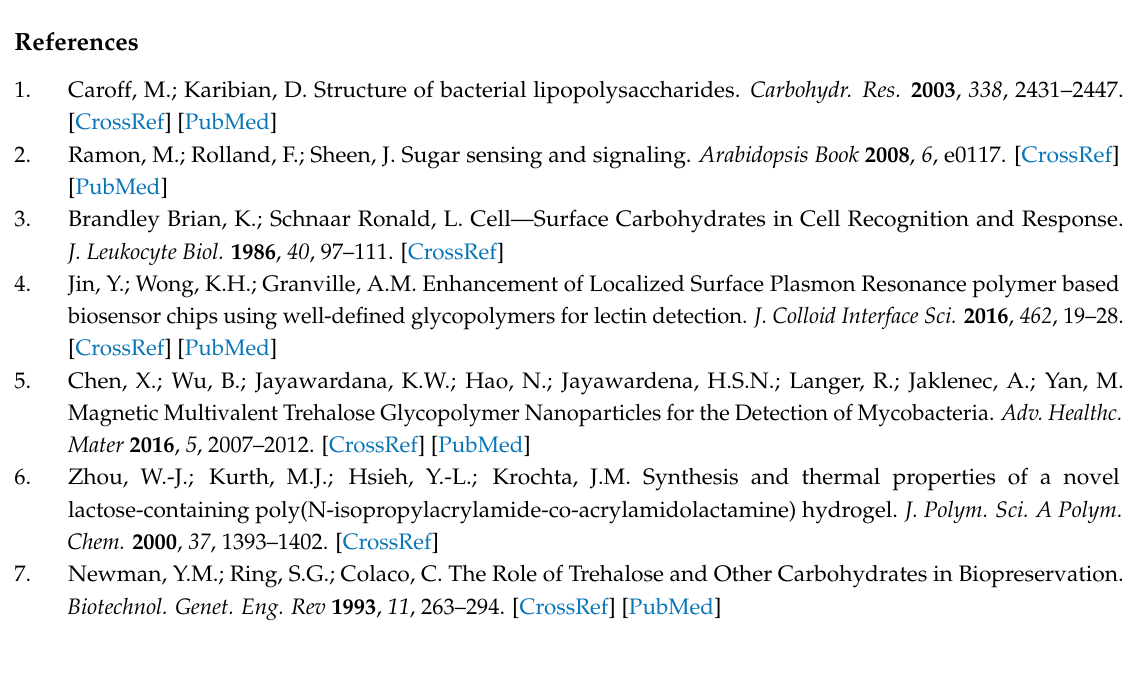
Supplementary Materials: Supporting information including detailed synthetic protocols, 1 H, 19 F and 31 P NMR and IR spectra are available